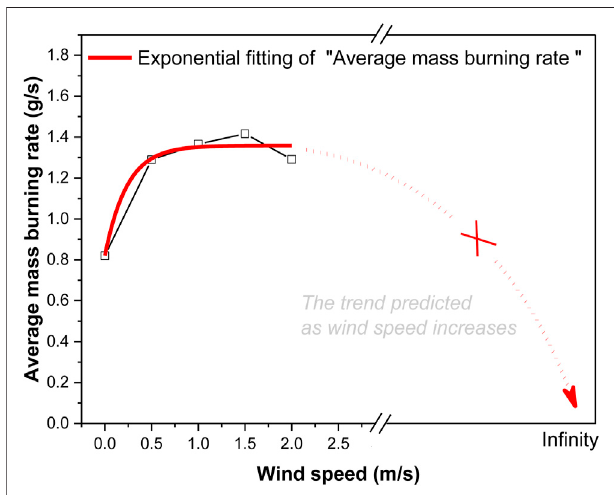
FIGURE3| Variation trendofthe average massburning rateduring FPU horizontal fl ame spread at different lateral wind speeds.